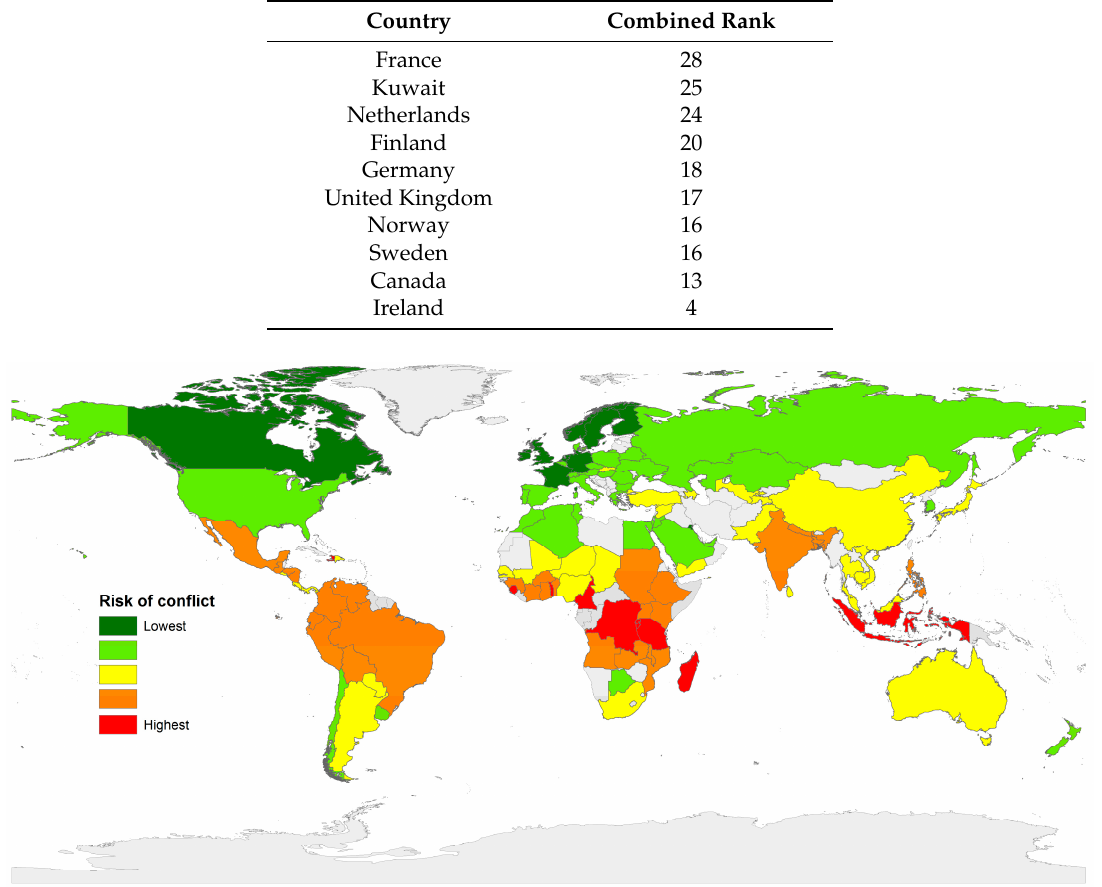
Table 2. Bottom 10 countries with lowest combined rank (shown in green on Figure 2).